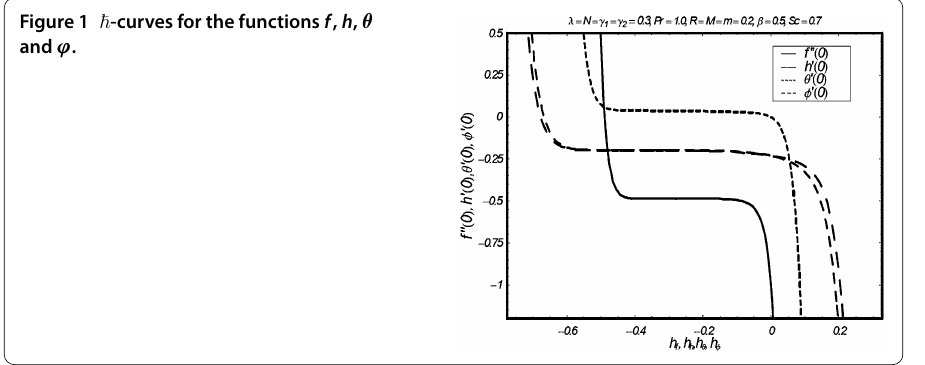
Figure 1 (cid:2) -curves for the functions f , h , θ and ϕ .